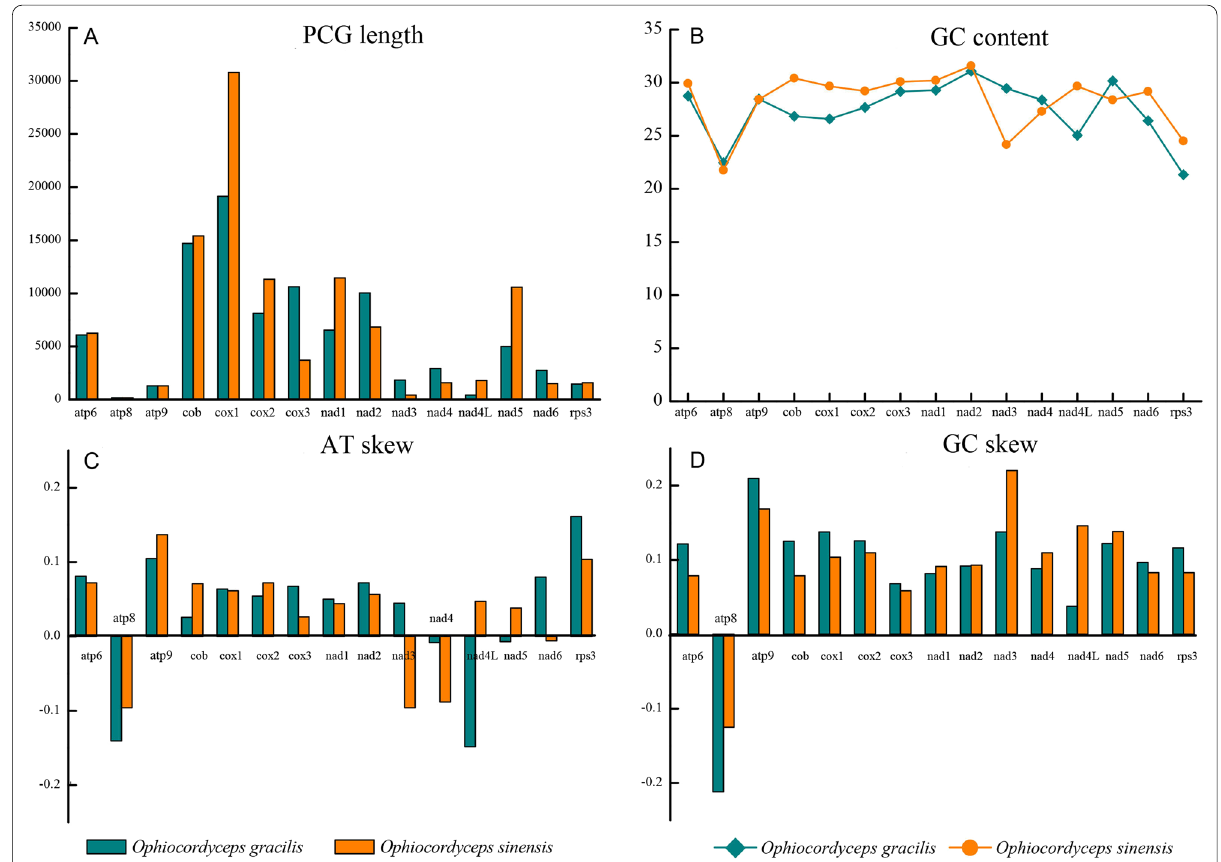
Fig. 4 Variation in the length and base composition of each of 15 protein‑coding genes (PCGs) between Ophiocordyceps gracilis and O. sinensis (Kang et al. 2017) . a PCGs length variation; b GC content; c AT‑stew; d GC‑stew. Light sea green represents O. gracilis , and orange represents O. sinensis